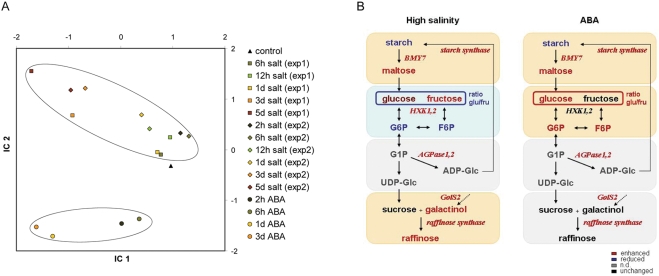
Common and distinct metabolic responses to high salinity and ABA.The metabolic response of 4 week old soil-grown Arabidopsis plants to high soil salinity and ABA was compared. (A) Independent component analysis (ICA) of metabolite data after salt stress and ABA treatment. IC1 gives high loadings to maltose, proline, phenylalanine, glutamine and glycine. IC2 gives high loadings to raffinose, galactinol and G6P. (B) Schematic representation of the starch to sucrose and RFO pathways after 3 days of treatment. Metabolites (bold) and genes (italic) whose levels were upregulated in comparison to controls are indicated in red whereas blue represents downregulation. Orange and blue shading indicate up- and downregulation of the modules within the metabolic pathways, respectively.